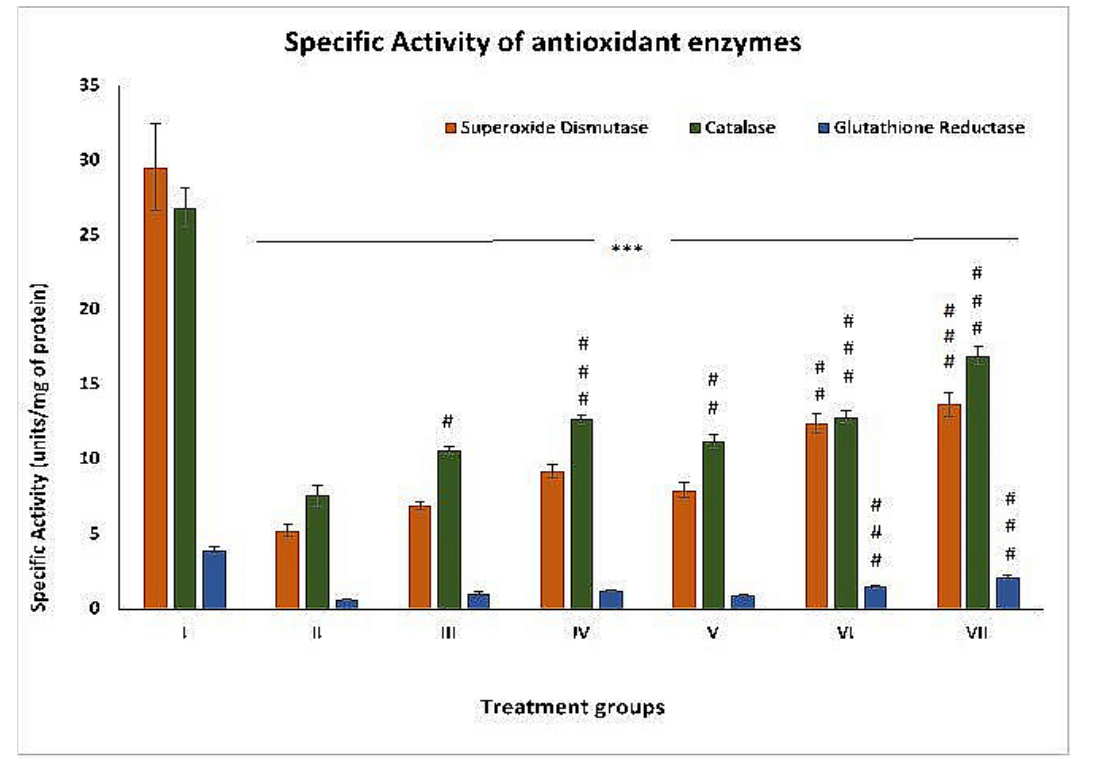
Figure 2. Effect of the treatment on the specific activity of antioxidant enzymes—copper-zinc superoxide dismutase (SOD), catalase (CAT), and glutathione reductase (GR) in liver samples of the indicated treatment groups expressed in units per milligram of protein in the sample. The asterisk mark * indicates values significantly different from the control (group I), while # indicates values significantly different from the control positive (group II). All experiments were conducted in triplicate, and the data are presented as the mean ± SEM. p -values were calculated by Student’s t-test, # p < 0.05; *** p < 0.001.